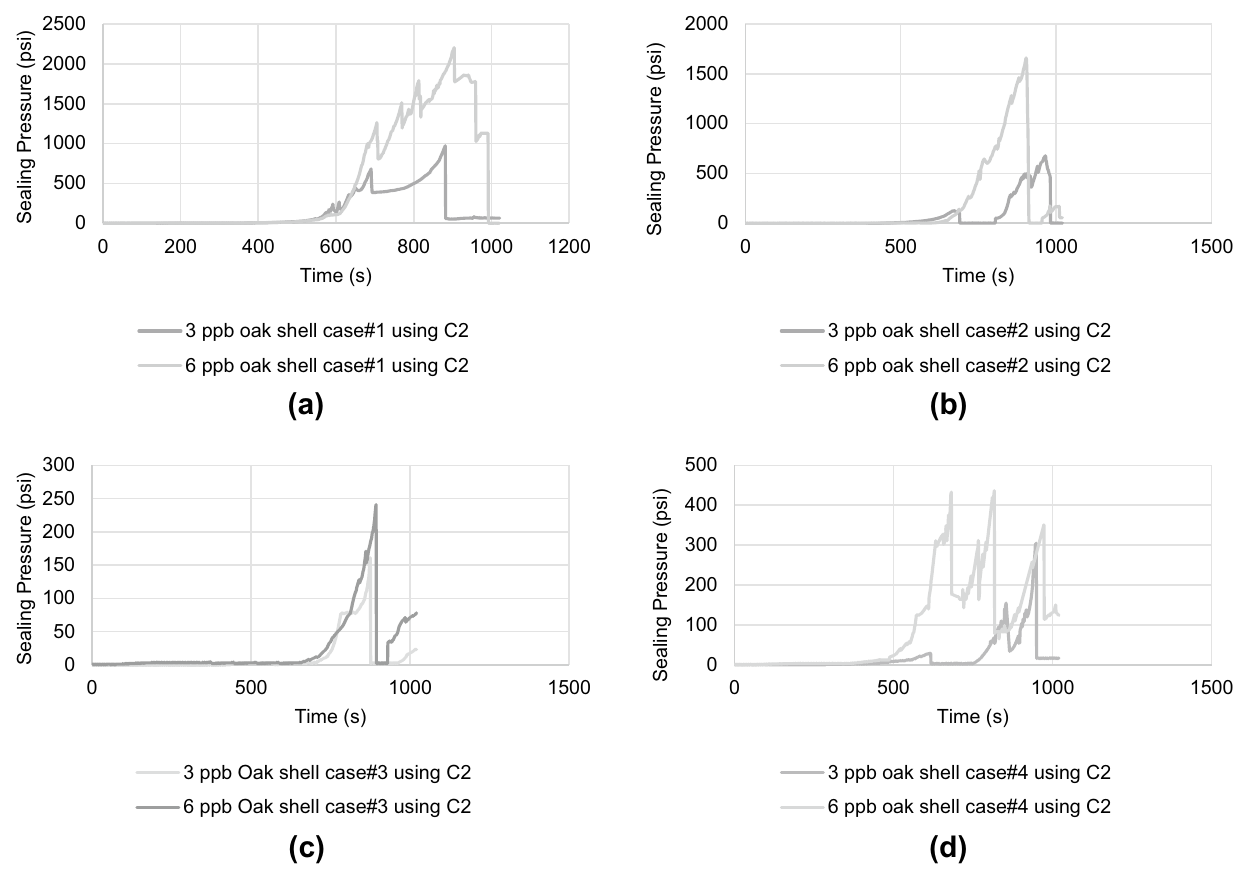
Fig. 26 HPA Pressure versus Time plot for Oak Shell showing maximum sealing pressure at different concentrations, a case#1, b case#2, c case#3, d